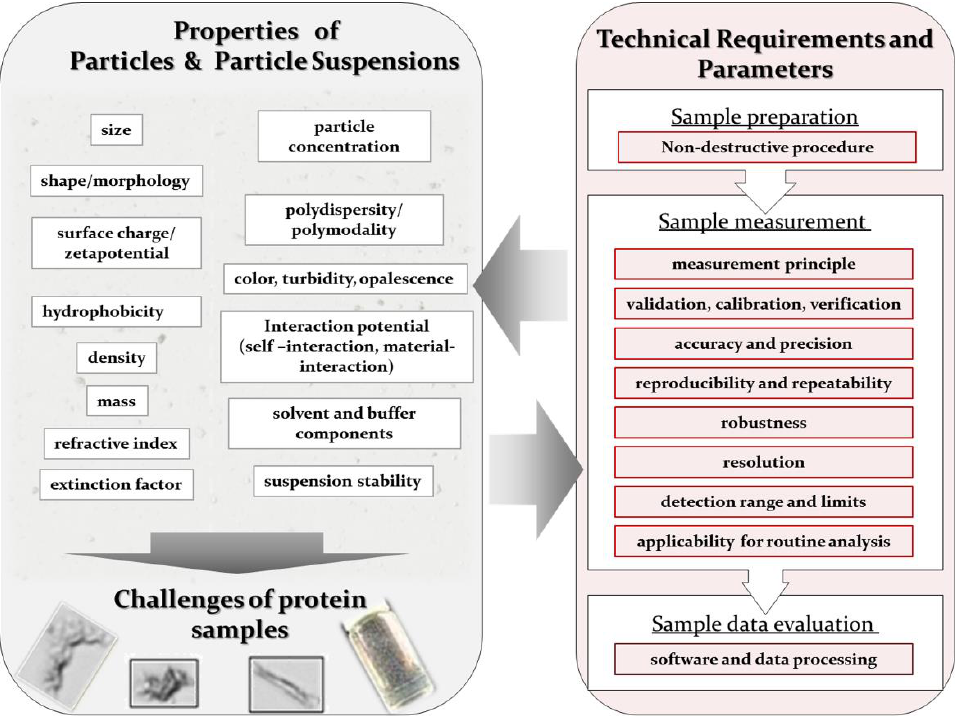
Figure 1. Particle properties and resulting technical requirements. The left part summarizes some of the most investigated properties of particles. The right part monitors the analytic workflow and points out technical parameters essential for particle detection techniques. Both parts need to be considered to identify a suitable technique and to interpret the results of an analysis.